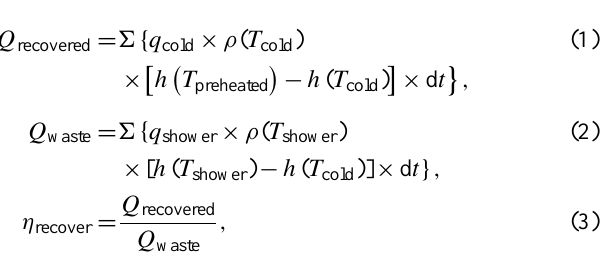
Table 1. Summary of experiments. Interval between showers (min)